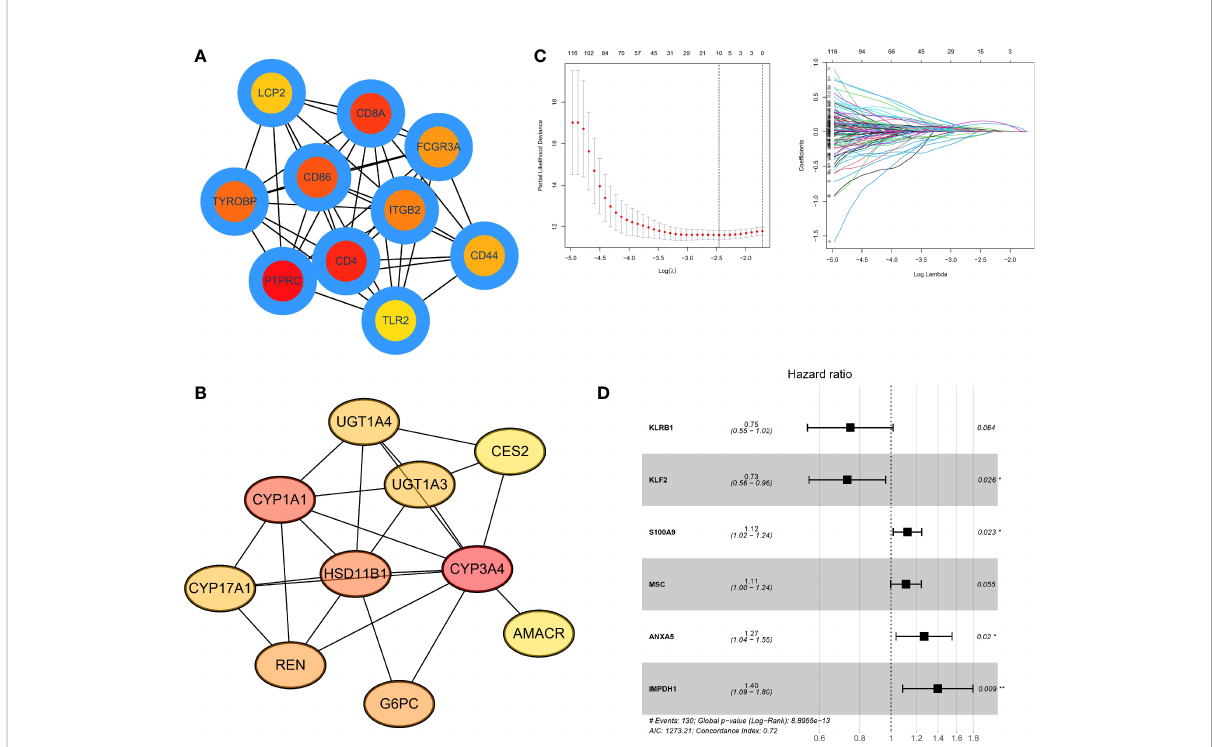
FIGURE 6 Identifying Hub genes and building predictive models (A) . PPI network listed the highest 10 hub genes within hot tumors (B) . PPI network listed the highest 10 central genes within cold tumors (C) . LASSO-COX regression model to identify genes in the training cohort and determine the prognostic model. The ordinate of the left fi gure represents the error of the model, and the lower ordinate is log( l ). There are two numerical dotted lines, the left is the line with the lowest error, and the right is the line with fewer features. The ordinate on the right is the value of the coef fi cient, and the abscissa is log( l ). As the value of l changes, the later the coef fi cient is compressed to 0, the more important the variable is. (D) . Forest plot showed a gene set of 6 genes predicting survival value. The genes after LASSO regression were analyzed by Cox regression using multivariable step-up regression method (*p < .05, **p <